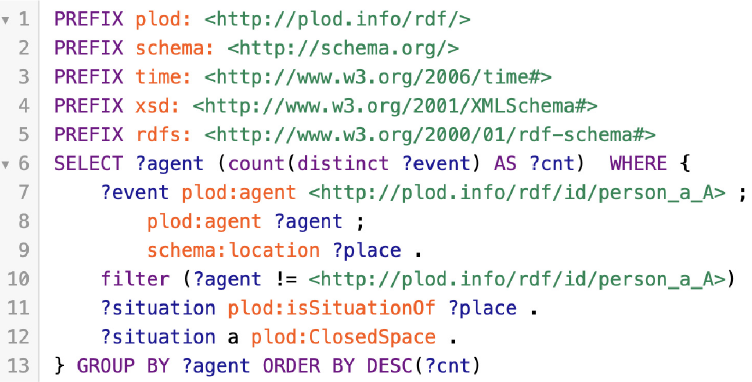
Fig 5. SPARQL query to retrieve the people who appear with Person A in the event of a closed situation, in descending order by the number of that